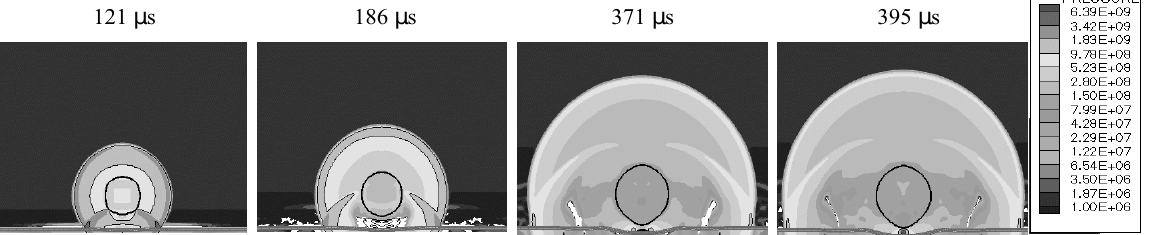
Fig. 10. Flat plate cavitation formation and collapse.